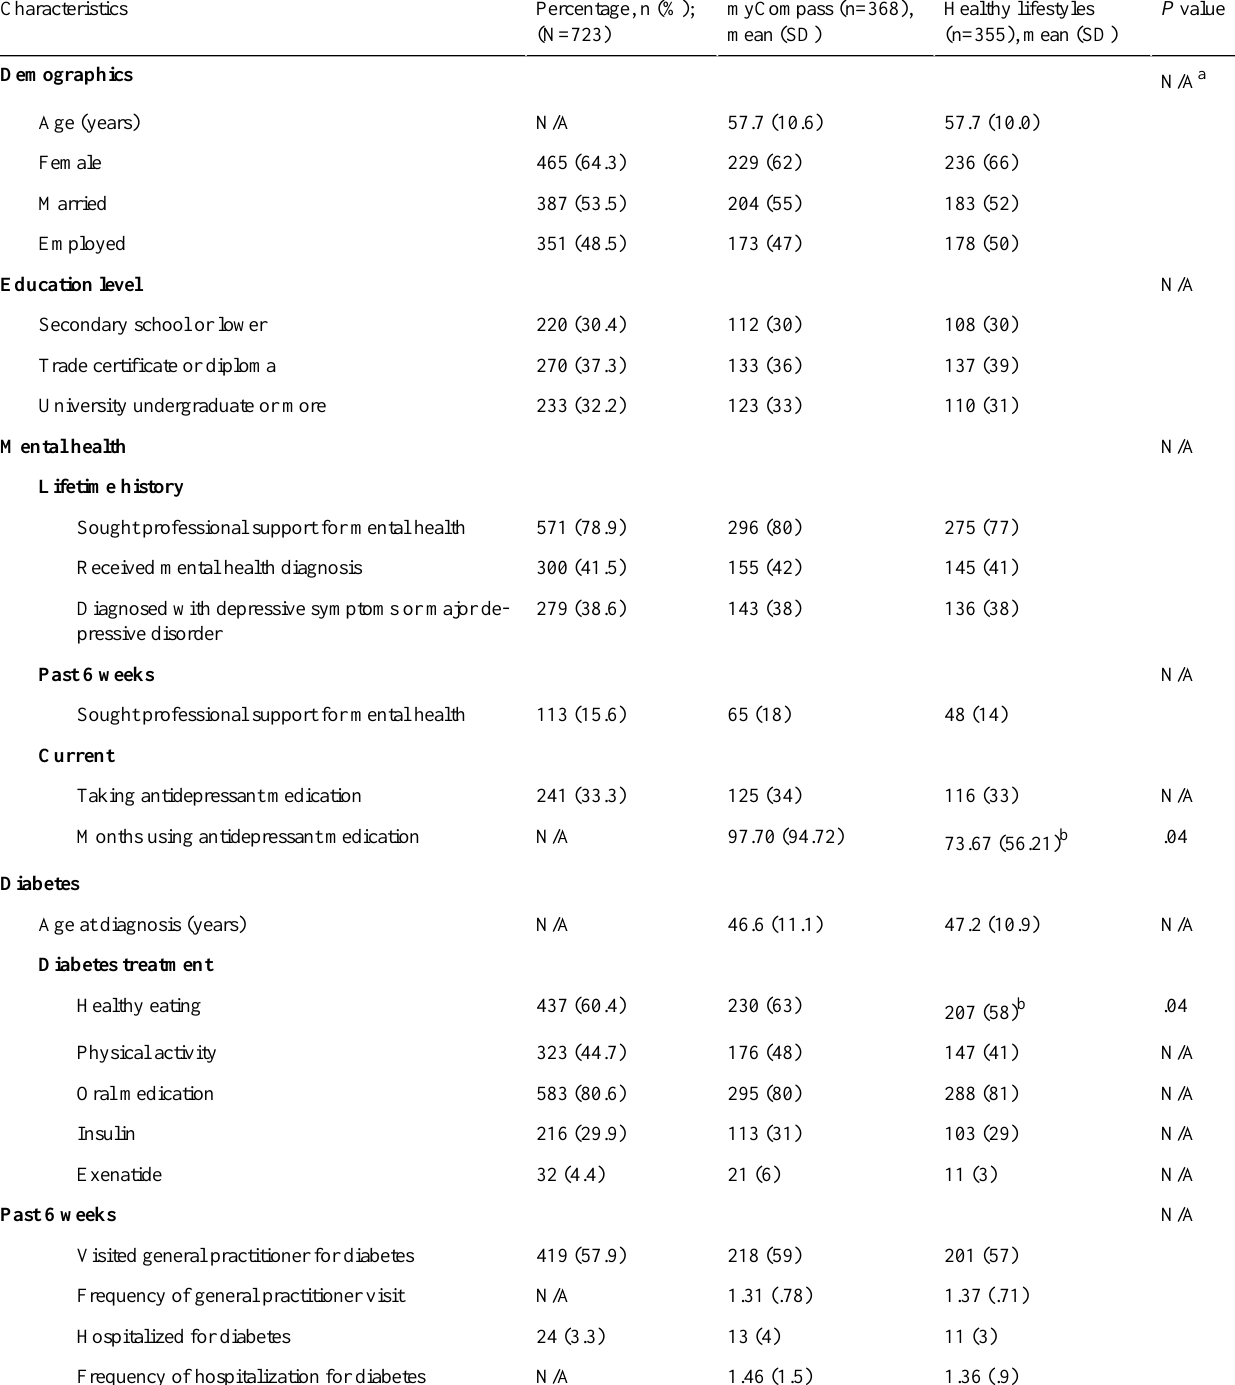
Table 2. Baseline means (SDs) for myCompass and Healthy Lifestyles